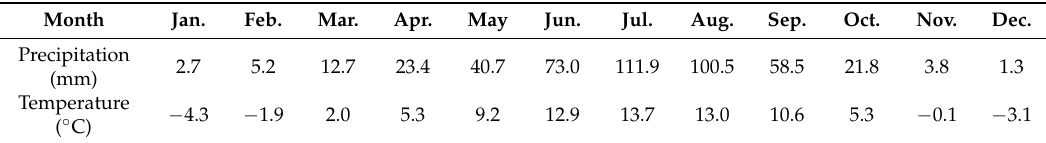
Table 8. Average monthly precipitation and temperature during 2001–2015.